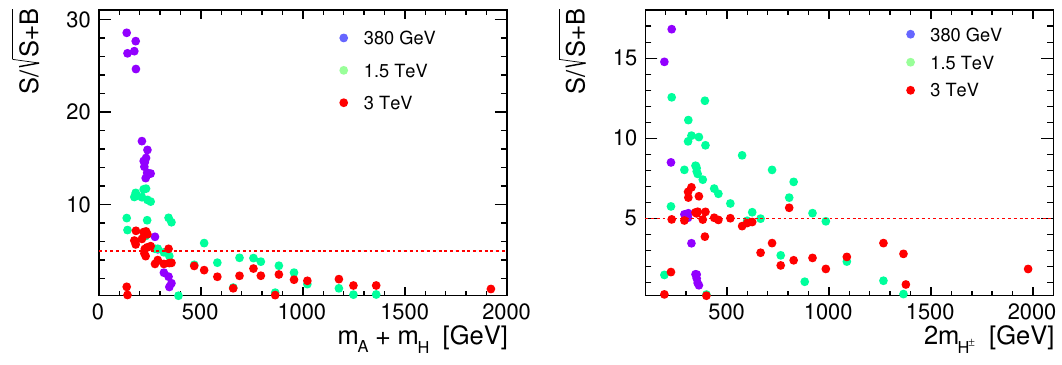
Figure 10 . Signi(cid:12)cance of the deviations from the Standard Model predictions expected at the subsequent CLIC stages for: (left) events with two muons in the (cid:12)nal state ( (cid:22) + (cid:22) (cid:0) ) as a function of the sum of neutral inert scalar masses and (right) events with an electron and a muon in the (cid:12)nal state ( e + (cid:22) (cid:0) or e (cid:0) (cid:22) + ) as a function of twice the charged scalar mass, for IDM benchmark points in tables 1 and